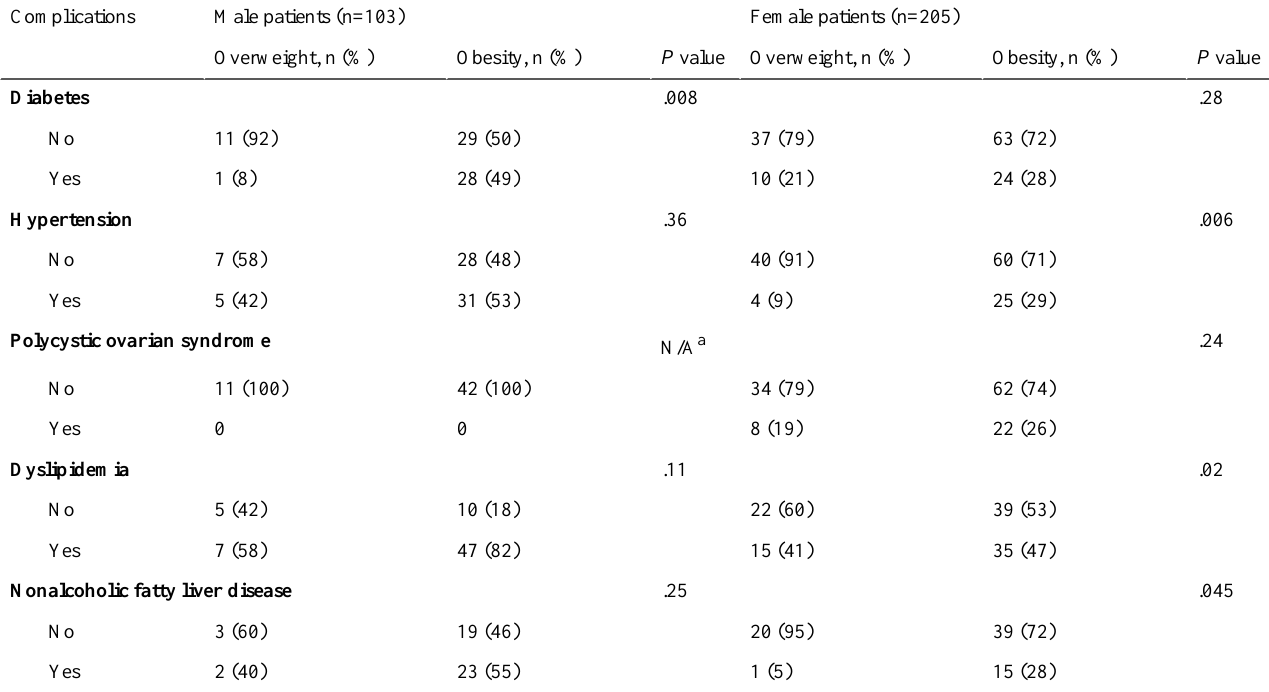
Table 1. Comparison of complications between patients with overweight and those with obesity by gender